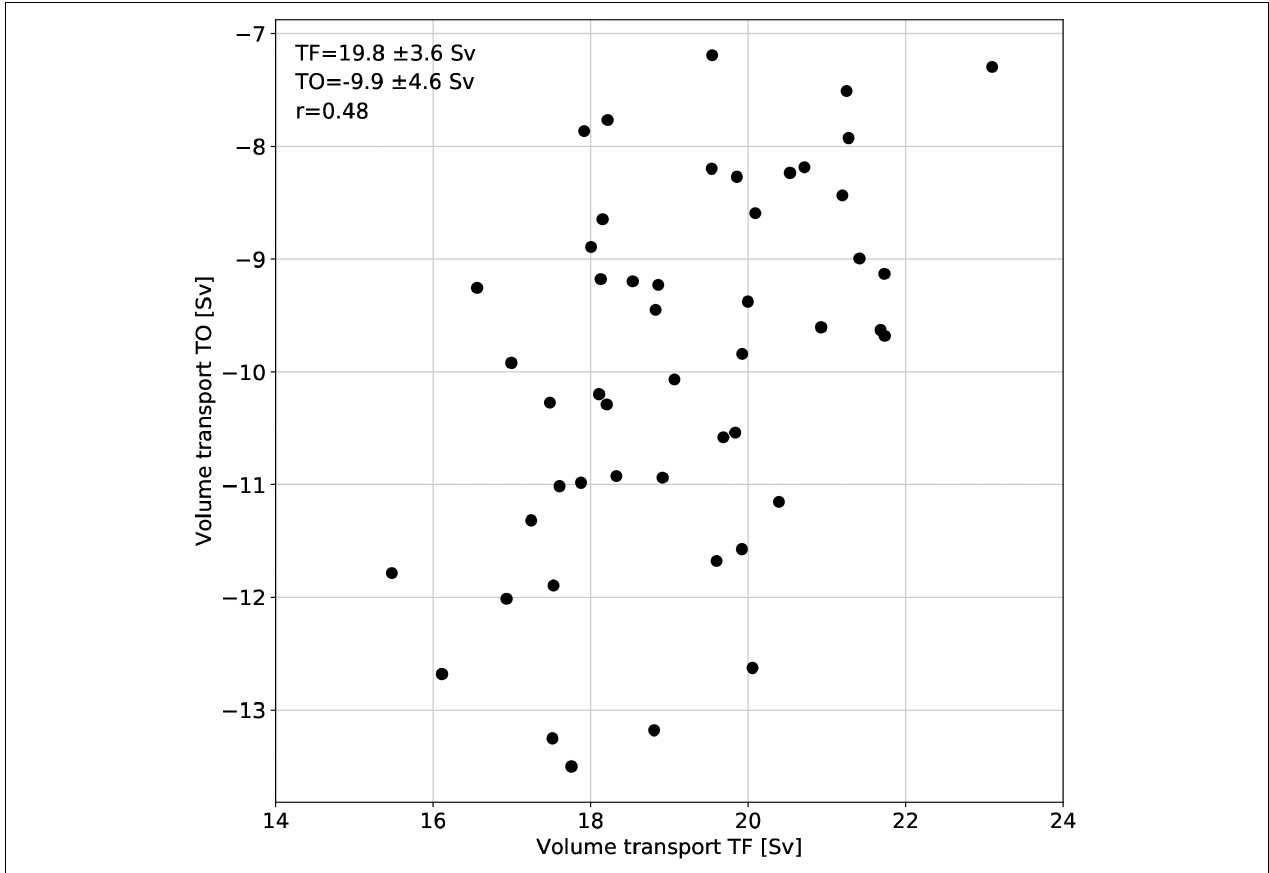
FIGURE 6 | Annual mean modeled volume transports for TF and TO, showing the gating between both transport pathways supplied by the EAC.